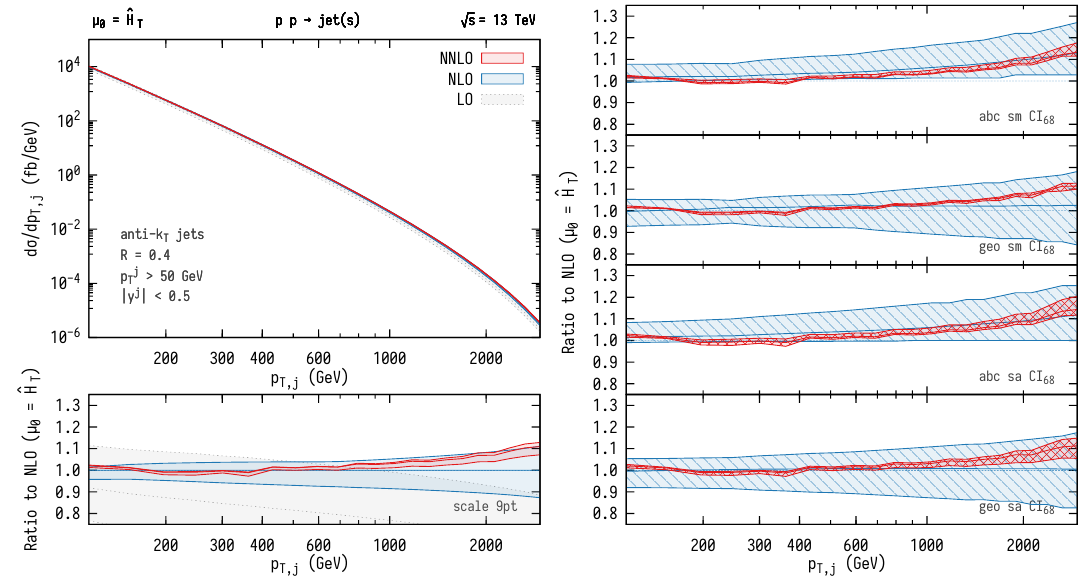
ˆ H T as the central scale choice. Left: